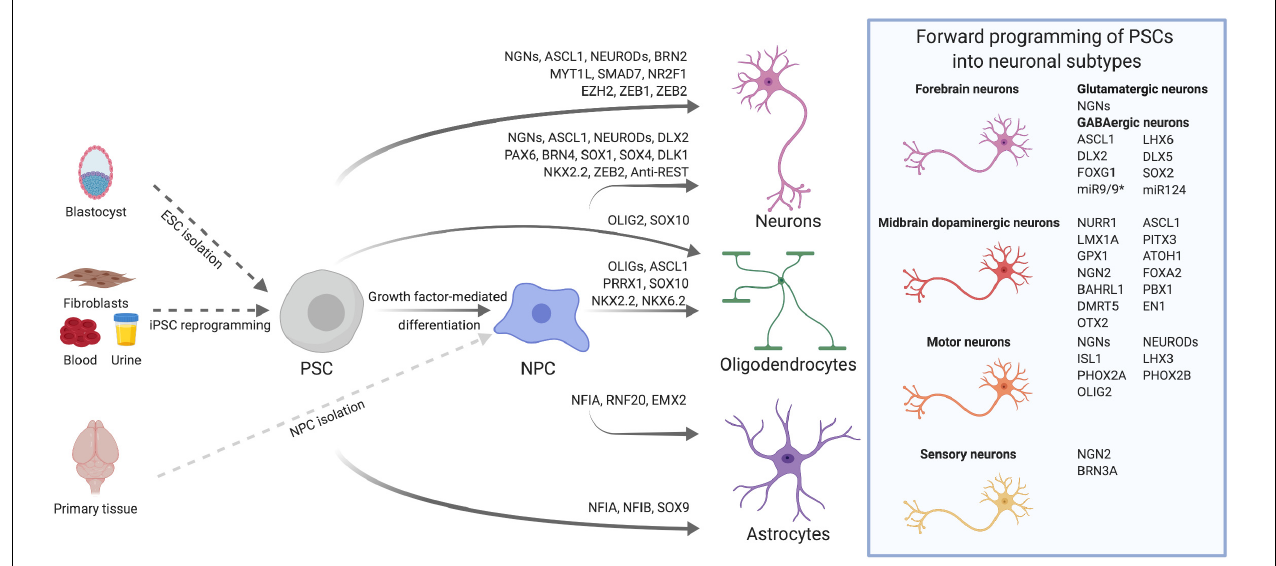
FIGURE 1 | Transcription factor-mediated specification of pluripotent stem cells and neural precursor cells. PSCs, such as ESCs derived from the blastocyst or iPSCs reprogrammed from somatic cells, as well as primary or PSC-derived NPCs can be differentiated into neurons, astrocytes and oligodendrocytes via overexpression of cell type-specific TFs. By using subtype- and/or region-specific TFs, forward programming approaches can be further refined to yield highly specified neuronal subtypes as for instance midbrain dopaminergic neurons. The TFs listed for the derivation of diverse neural cell types were either used alone or in combination. Further details on TF combinations are provided in the main text and in Tables 1 , 2